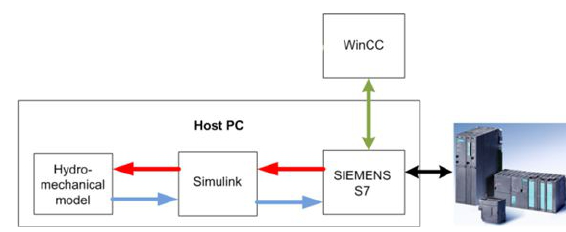
Figure 12. HIL setup for active heave compensation of